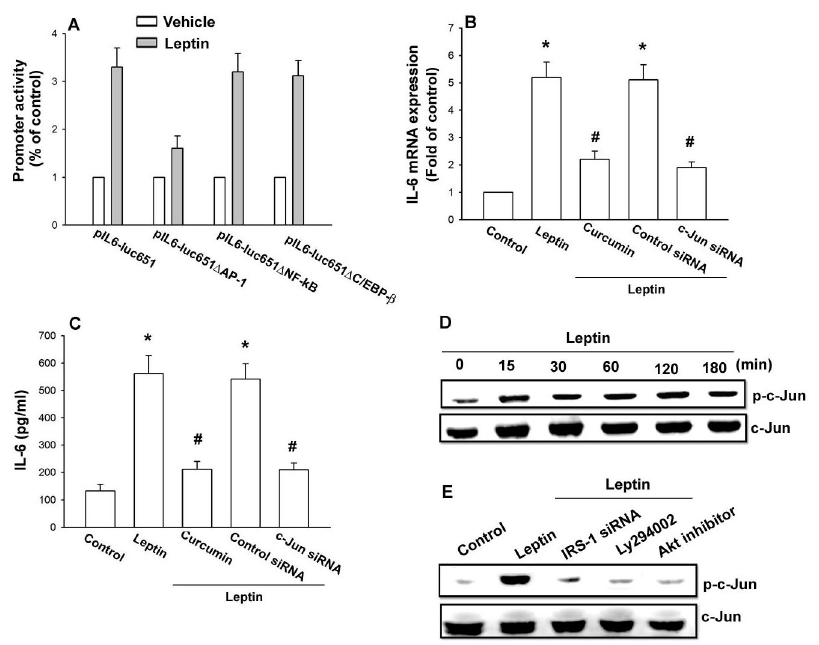
Figure 5. Involvement of AP-1 in leptin induced IL-6 production. (A) OASFs were transfected with indicated IL-6 promoter luciferase plasmids for 24 h. Cells were then incubated with leptin (3 µM) for 24 h. IL-6 luciferase activity was measured, and the results were normalized to β-galactosidase activity and expressed as the mean ± SE for 3 independent experiments performed in triplicate (n=4). (B and C) OASFs were pretreated for 30 min with curcumin or transfected for 24 h with c-Jun siRNA, followed by stimulation with leptin for 24 h. Media and total RNA were collected, and the expression of IL-6 was examined by qPCR and ELISA assay (n=4). (D) OASFs were incubated with leptin for the indicated time intervals. Total protein was collected and the phosphorylation of c-Jun was examined by western blotting (n=4). (E) OASFs were pretreated with Ly294002 and Akt inhibitor for 30 min or transfected with IRS-1 siRNA for 24 h and then incubated with leptin for 120 min. Total protein was collected and the phosphorylation of c-Jun was examined by western blotting (n=4). Results are expressed as mean ±S.E.M. of four independent experiments. *: p < 0.05 as compared with basal level. #: p < 0.05 as compared with the leptin-treated group. doi: